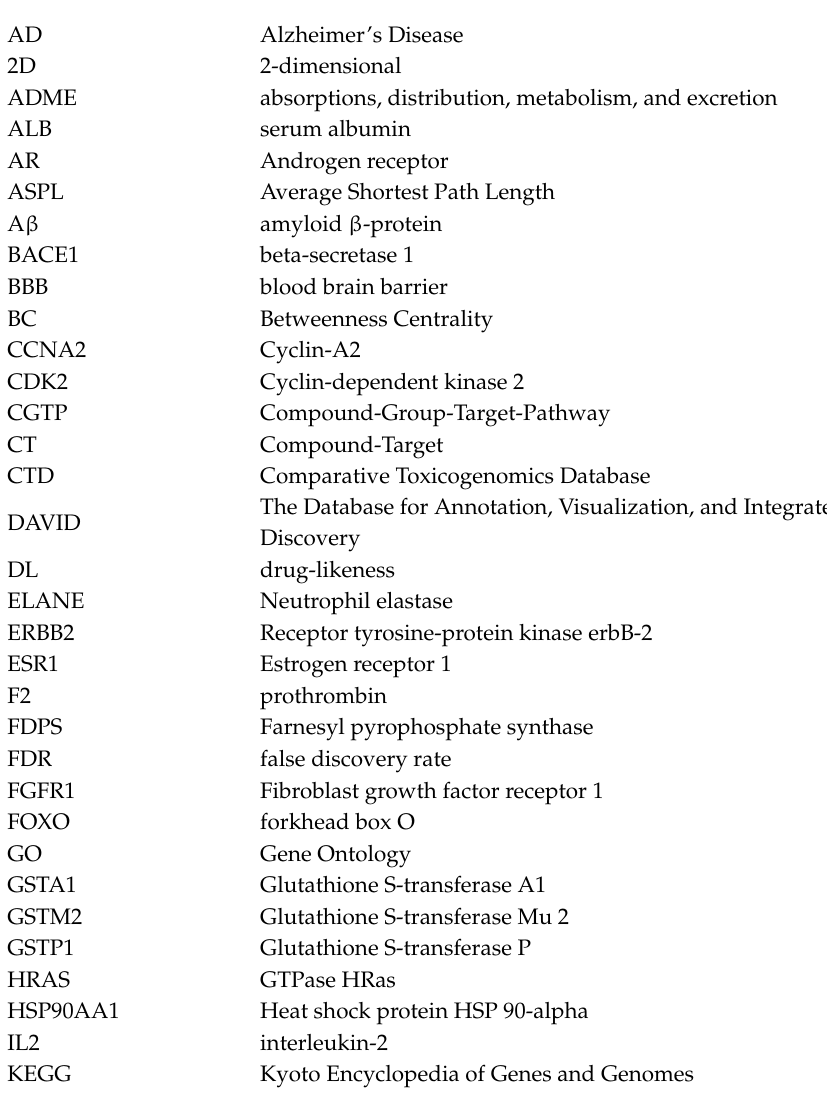
Table S1: Result of 25 candidate compounds of Ginkgo biloba . Table S2: Inverse Docking Results of the 25 candidate compounds of Ginkgo biloba L. Table S3-1: AD-associated gene information collected from Comparative Toxicogenomics Database (CTD). Table S3-2: AD-associated target proteins information collected from Comparative Toxicogenomics Database (CTD). Table S4-1: AD-associated gene information collected from GeneCards. Table S4-2: AD-associated target proteins information collected from GeneCards. Table S5: Top 30 putative target proteins according to Integrated Score. Table S6: Results of Gene Ontology enrichment for top 30 putative target proteins. Table S7: Results of pathway enrichment for top 30 putative target